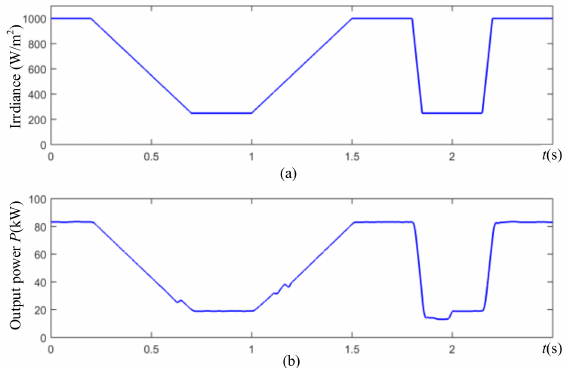
Figure 9. ( a ) Fluctuation curve of irradiance; ( b ) Output power of PV